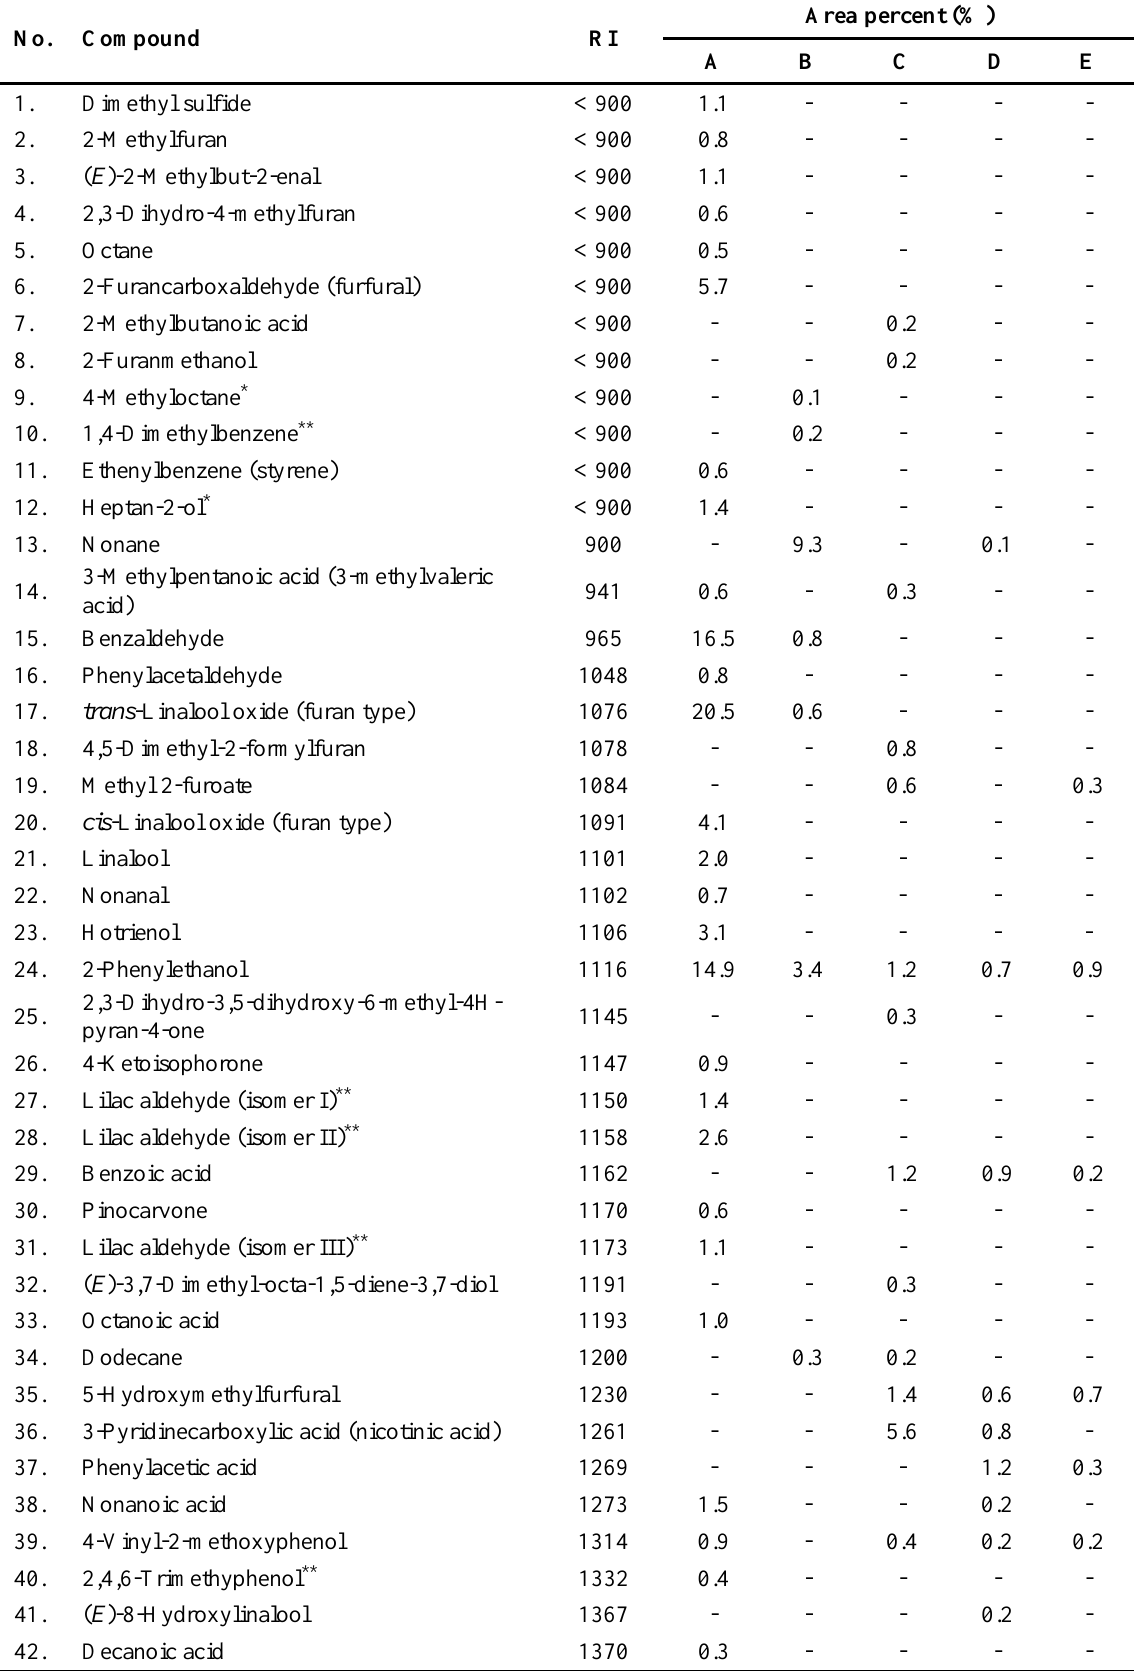
Table 1. Acer spp. honey volatile organic composition obtained by HS-SPME and USE followed by GC and GC/MS